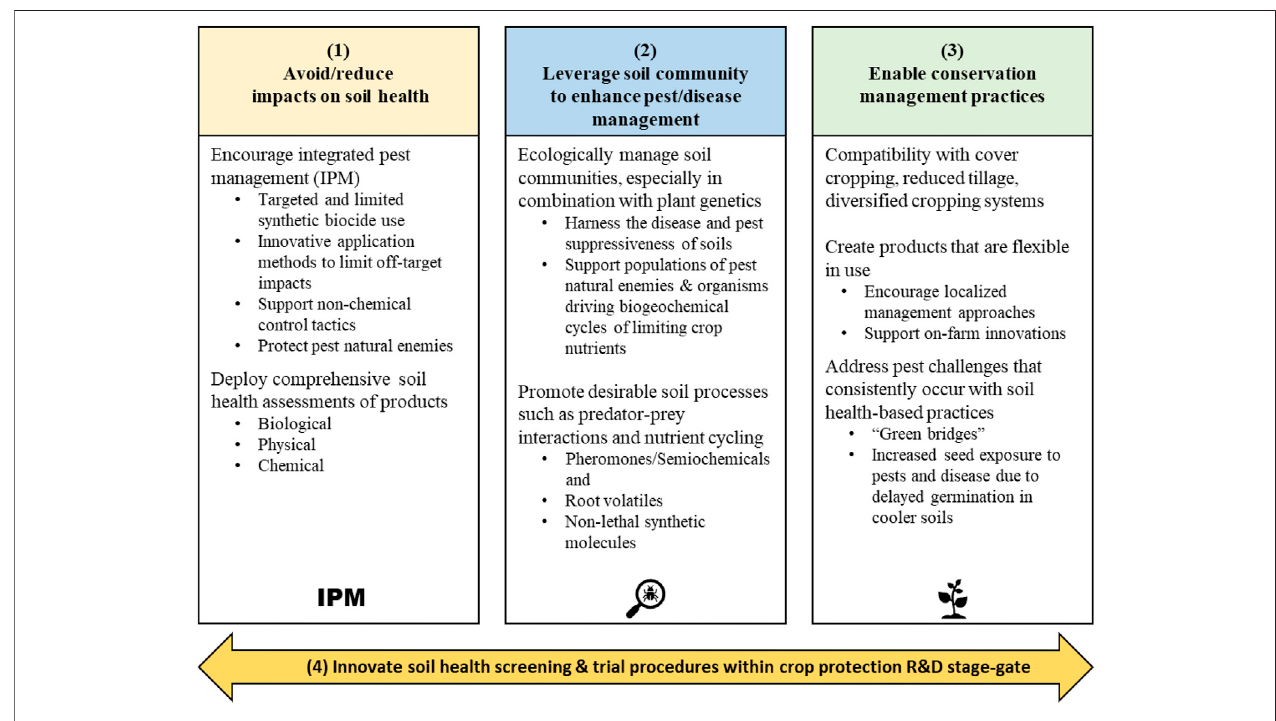
FIGURE 1 | Four key opportunities for the crop protection industry to innovate new technologies around soil health.